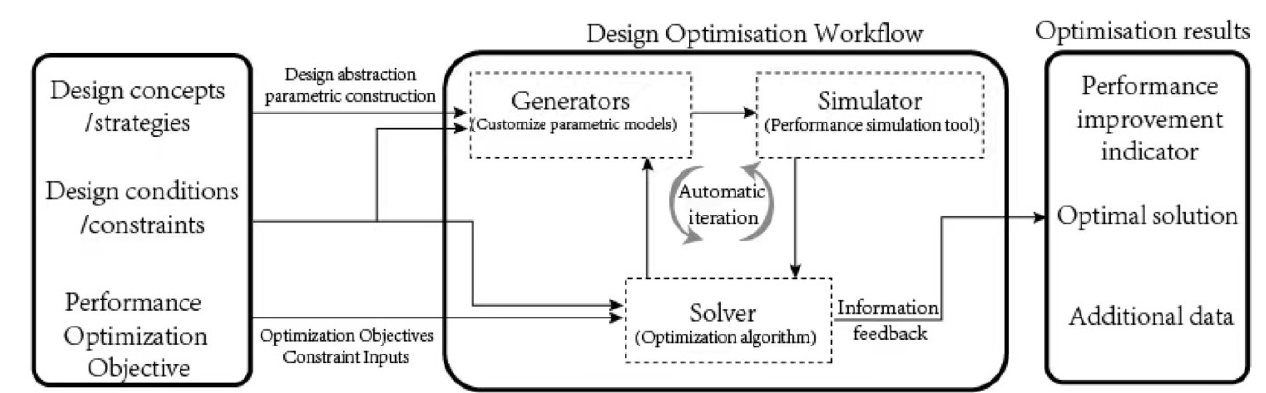
Figure 8. Design optimization application workflow diagram.